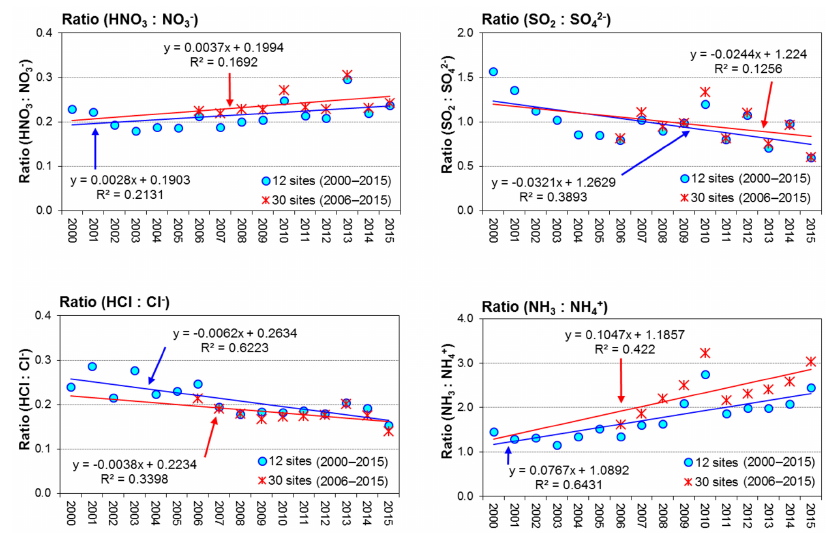
Figure 16. Long-term trends in the gas:aerosol ratio, from a comparison of the annual mean concentrations of 12 sites with complete time series from 2000 to 2015, and 30 sites with complete time series from 2006 to 2015, showing indicative differences in direction of trends in this ratio with time.